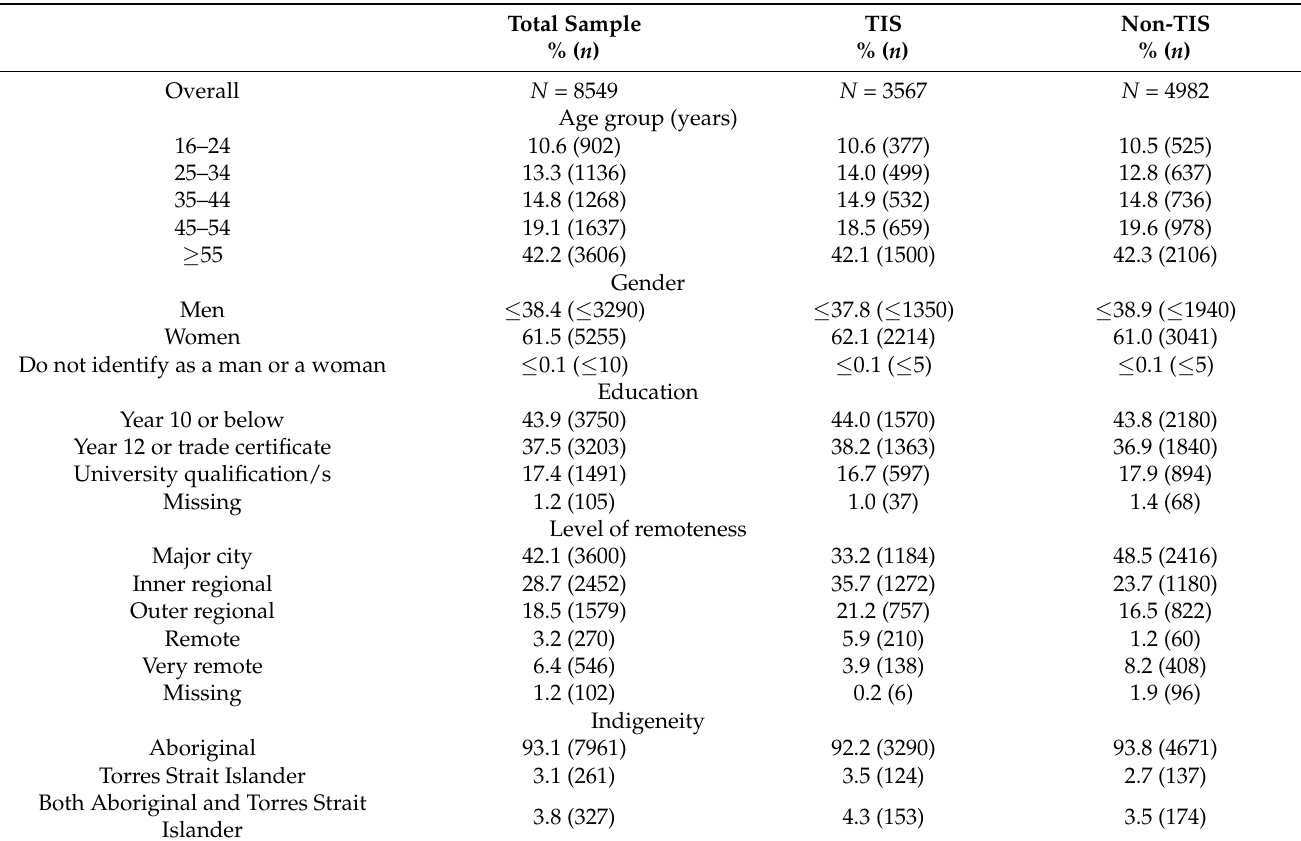
Table 2. Demographic characteristics of Mayi Kuwayu Study baseline participants, overall and by TIS/non-TIS.